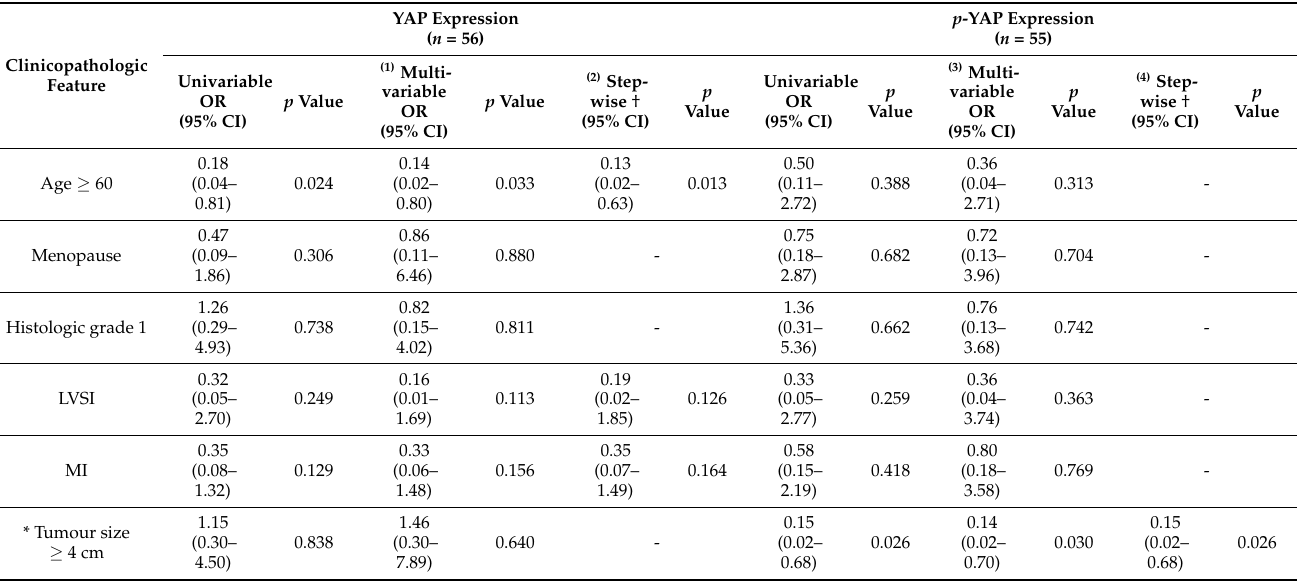
Table 4. Logistic regression analysis of YAP and p -YAP expression in endometrial cancer.